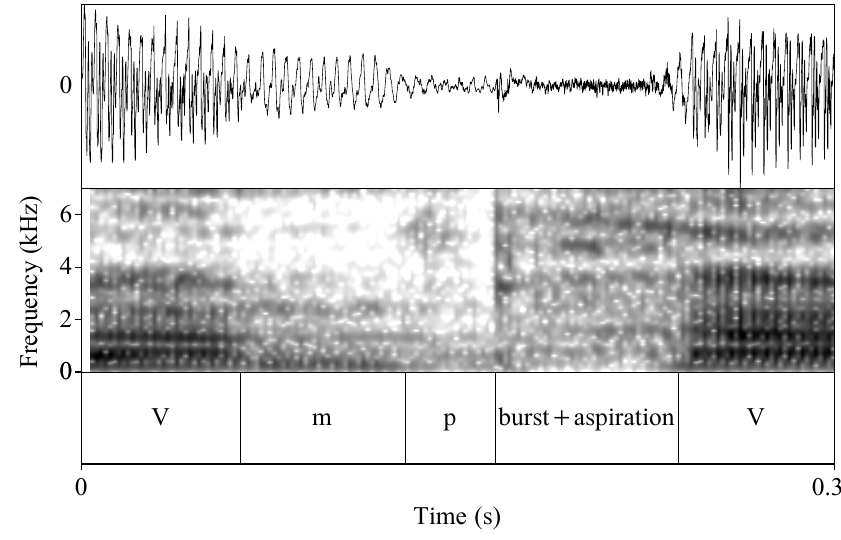
Figure 4: Sound wave, spectrogram and text grid of /mp h